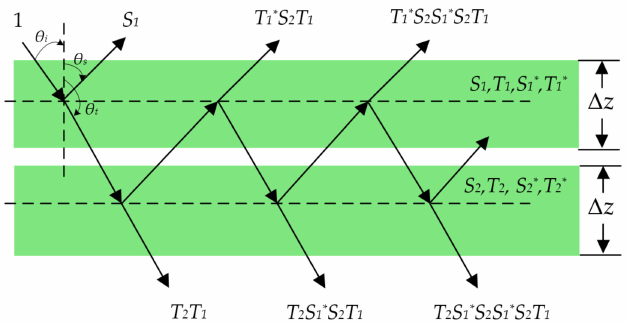
Figure 4. The process of using the Matrix Doubling Algorithm to calculate the multiple scattering of unit incident power between two close thin